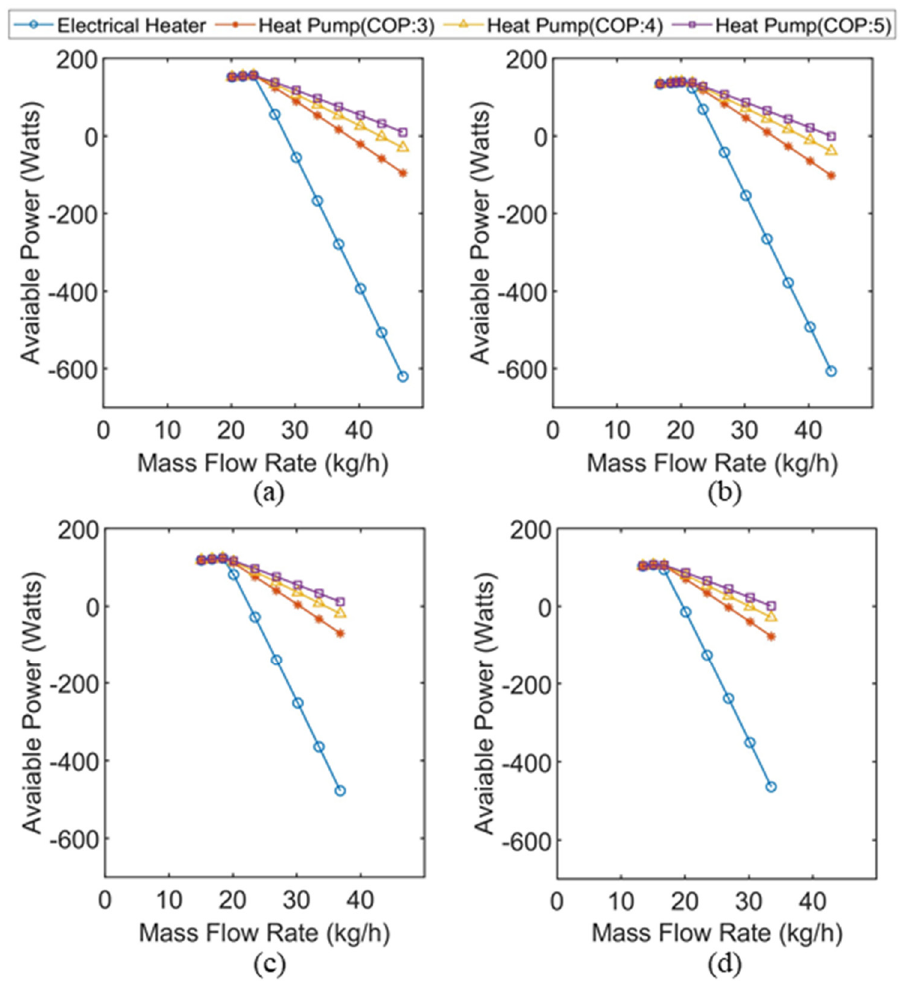
Figure 7. Available electrical power after delivering domestic hot water by different backup systems coupled with evacuated PVT system at irradiance of: ( a ) 1000 W/m 2 ; ( b ) 900 W/m 2 ; ( c ) 800 W/m 2 ; ( d ) 700 W/m 2 .